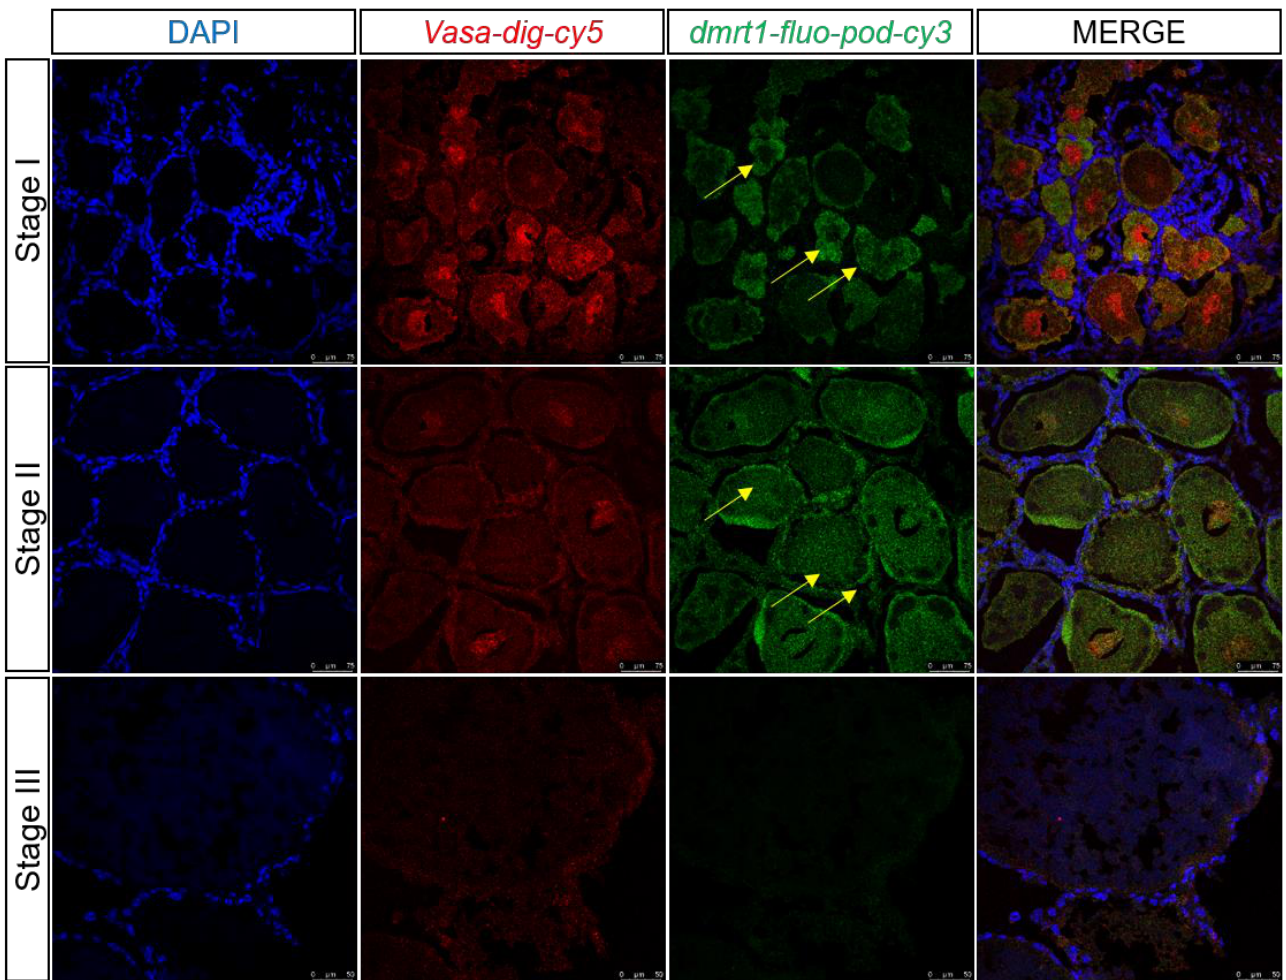
Figure 9. Two-color fluorescent in situ hybridization showing expression profiles of dmrt1 and vasa in the ovary at different stages (scale, Stage I, II: 75 μm; Stage III: 50 μm). Blue signal: DAPI; red signal: vasa ; and green signal: dmrt1 .The yellow arrow marks the green signal.